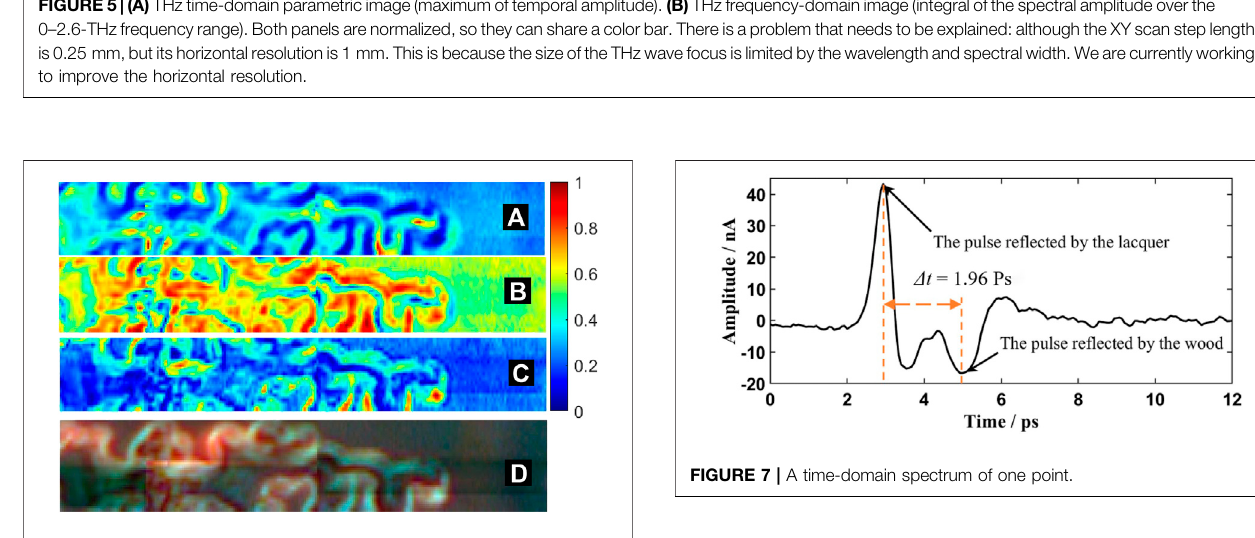
FIGURE 6 | THz re fl ection frequency spectrum composite image. (A) The image is recorded in the 0.16113 – 0.45410 THz range. (B) The image is recorded in the 1.112,790 – 1.42090 THz range. (C) The image is recorded in the 1.81640 – 2.10940 THz range. (D) The image is synthesized via false RGB. (a) Image of the red channel, (b) image of the green channel, and (c) image of the blue channel. The panels arebeen normalized to share a color bar.